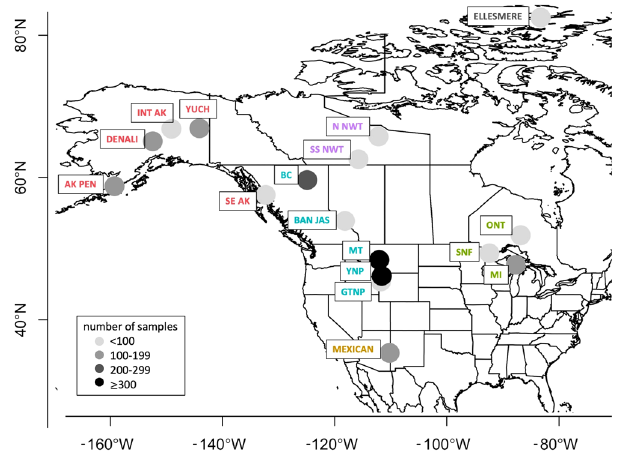
Figure 1. A map 38 depicting where wolves were sampled across North America for pathogen and parasite testing, and relative sample size from each study area is shown in shades of gray (increasingly dark gray = increasing sample size) 39 . Each study area is identified as follows: Alaska Peninsula (AK PEN), Denali National Park (DENALI), central-eastern Alaska (INT AK), Yukon-Charley Rivers National Preserve (YUCH), Ellesmere Island (ELLESMERE), North Slave Northwest Territories (N NWT), South Slave Northwest Territories (SS NWT), British Columbia (BC), southeastern Alaska (SE AK), Banff and Jasper National Parks (BAN JAS), Montana (MT), Yellowstone National Park (YNP), Grand Teton National Park (GTNP), Mexican wolves (MEXICAN), Ontario (ONT), Superior National Forest (SNF), and the Upper Peninsula of Michigan (MI). Study area labels were colored by region: High Arctic (gray), Subarctic (purple), Alaska (red), central Rocky Mountains (turquoise), Great Lakes (green), and Mexican (gold), and displayed as a circle with a 200-km radius.